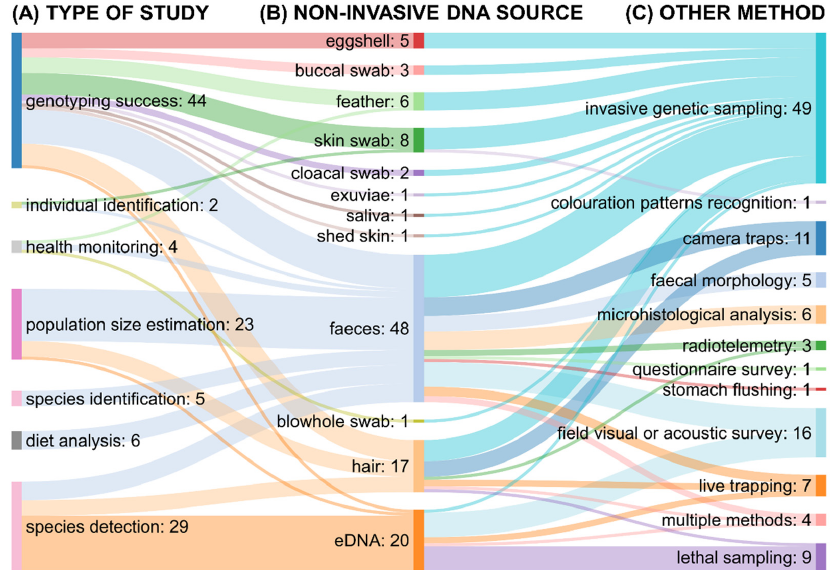
Figure 3. Sankey diagram with the number of studies grouped according to the type of study ( A ), source of a non-invasively obtained DNA sample ( B ), and method compared to the non-invasive genetic assessment ( C ). The thickness of the lines linking categories is proportional to the number of studies and the colour corresponds to the target category going from left to right.